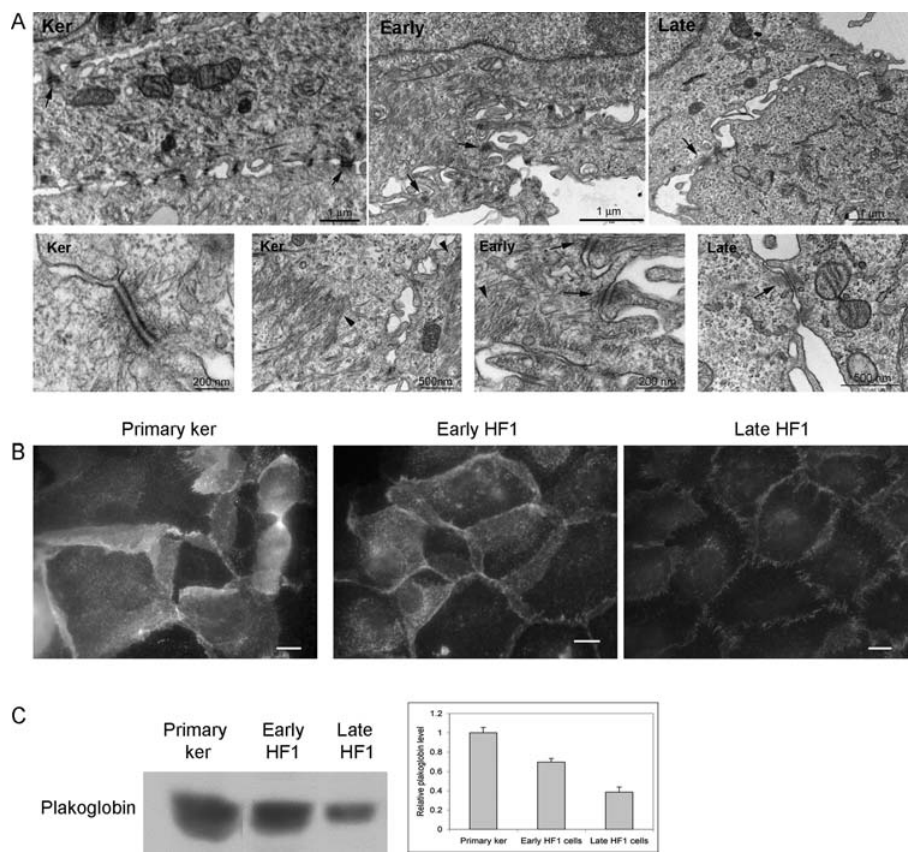
Figure 1. Desmosomes and cytokeratin are gradually reduced in the course of transformation. A. Primary keratinocytes, early and late HF1 cells were examined by transmission electron microscopy (TEM). Arrows show representative desmosomes, and arrowheads point to areas of cytokeratin bundles. B. Representative immuno-fluorescence images of plakoglobin staining. Bar=15 m m. C. Western blot analysis of plakoglobin expression in the primary keratinocytes, early and late HF1 cells. Graph shows quantification of three experiments.